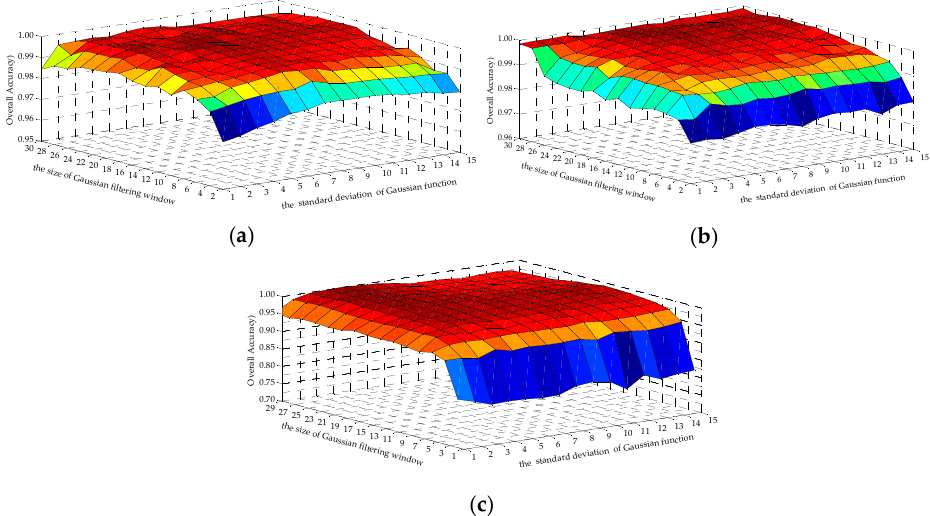
Figure 5. The relationship of the Gaussian filter window ( S ), standard deviation of the Gaussian function ( σ ), and overall accuracy (OA) in the three datasets. ( a ) Indian Pines; ( b ) Salinas; ( c ) Pavia University.